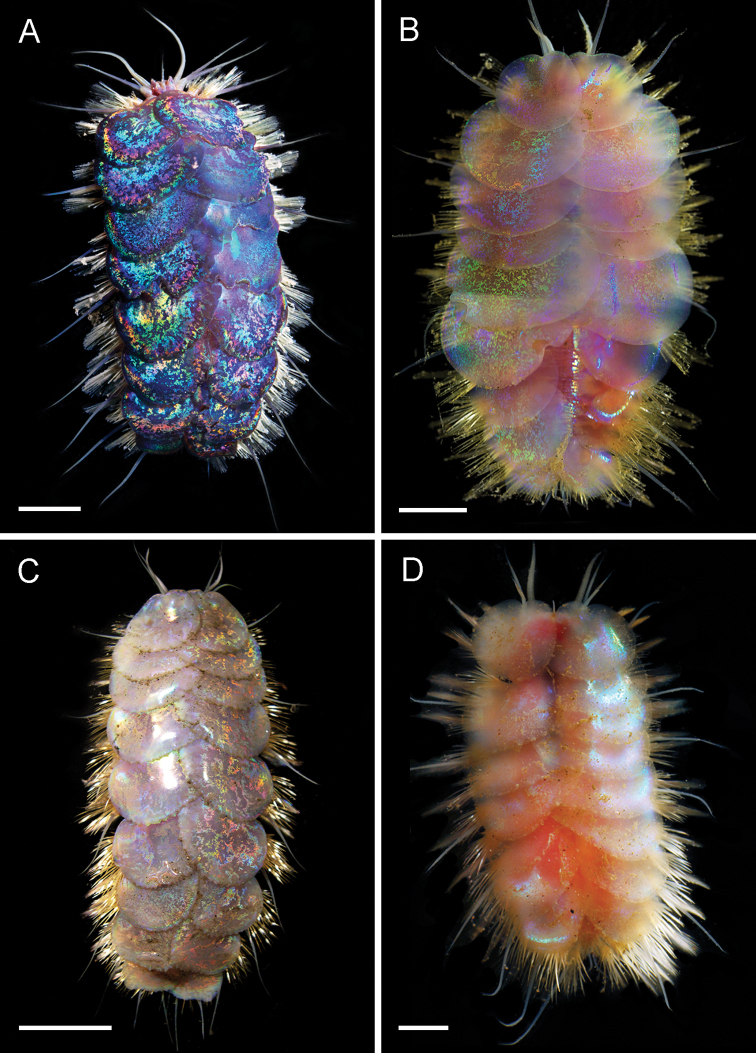
Live dorsal views of the new Peinaleopolynoe spp. APeinaleopolynoe
orphanae sp. nov. holotype SIO-BIC A6151 BPeinaleopolynoe
elvisi sp. nov. holotype SIO-BIC A8488 CPeinaleopolynoe
goffrediae sp. nov. holotype SIO-BIC A5485 DPeinaleopolynoe
mineoi sp. nov. holotype SIO-BIC A10071. Scale bars: 6 mm (A); 8 mm (B, C); 1 mm (D).